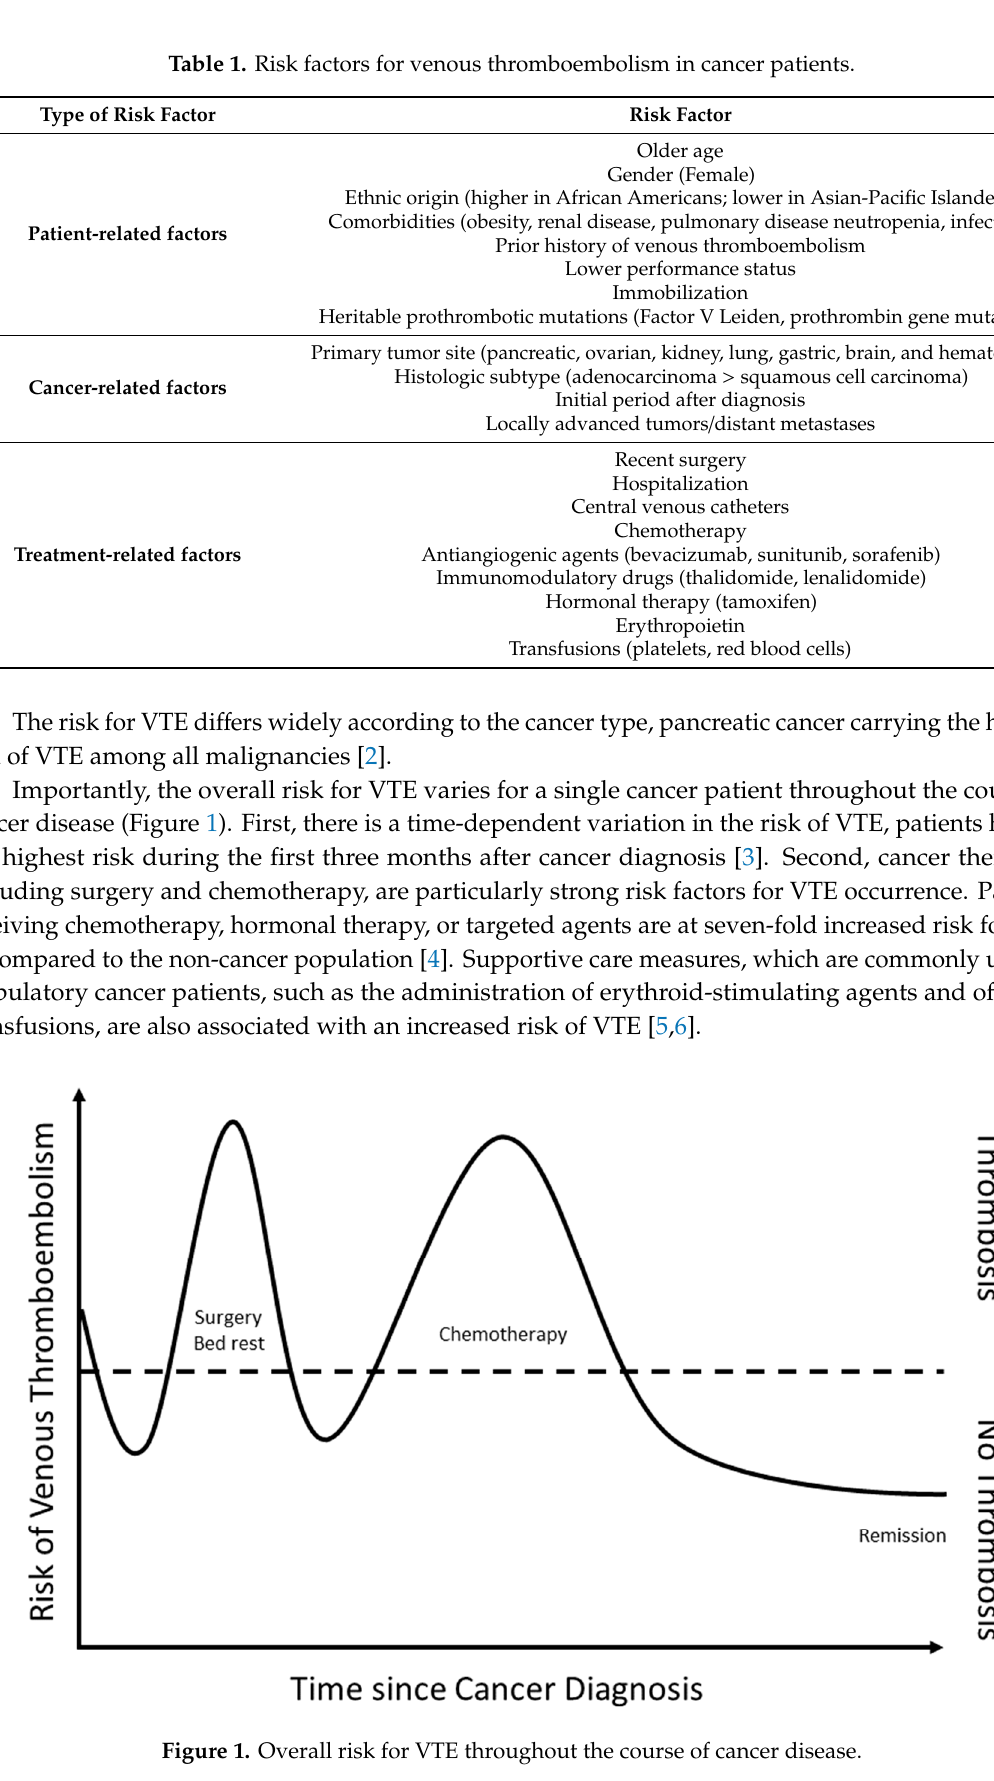
Figure 1. Overall risk for VTE throughout the course of cancer disease.